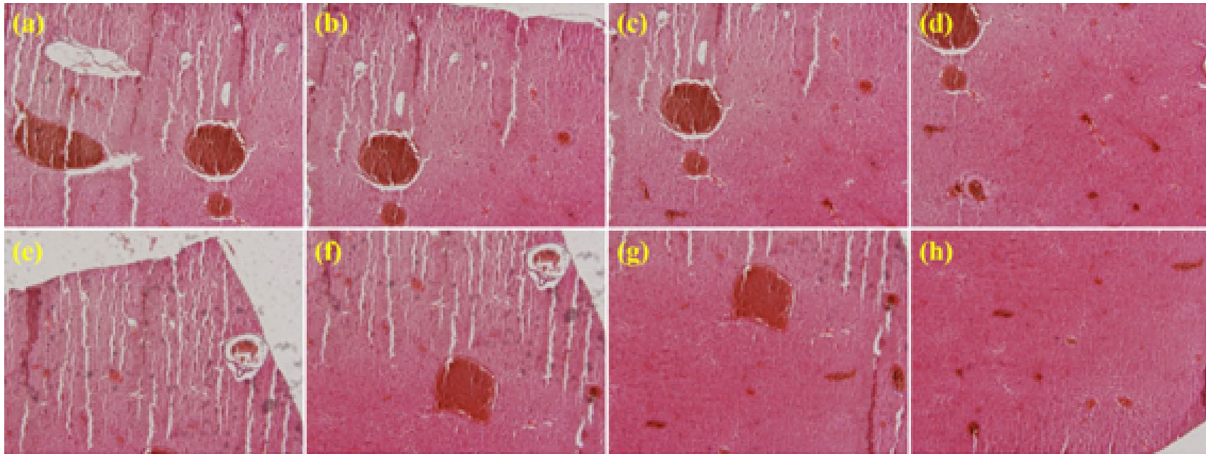
Figure 6. High magnification of H&E counterstain of ( a-d) rGO/MIL-125(Ti)@DOX@PdL, and (e–h) rGO/ MIL-125(Ti)@DOX on rat